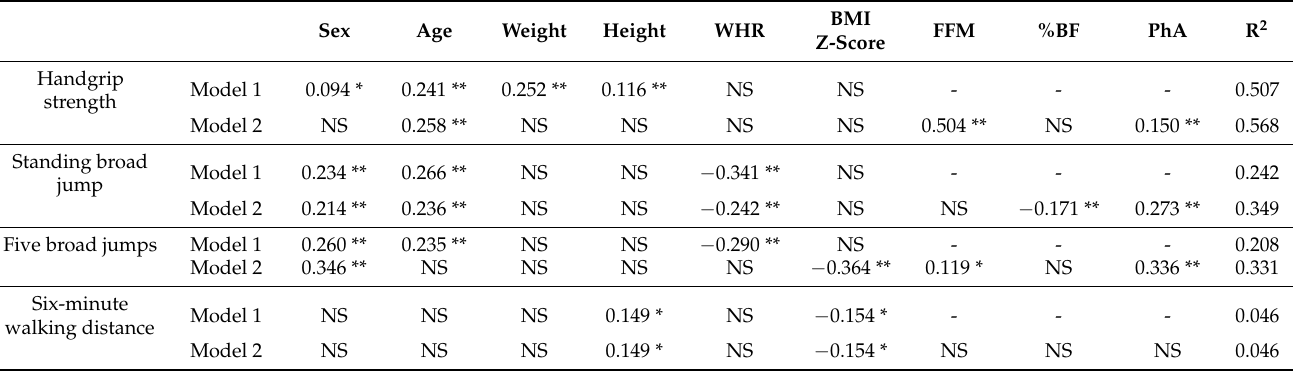
Table 4. Predictors of health-related physical fitness in the whole study group taking into consid- eration demographic and anthropometric variables only (Model 1) or body composition and BIA variables (Model